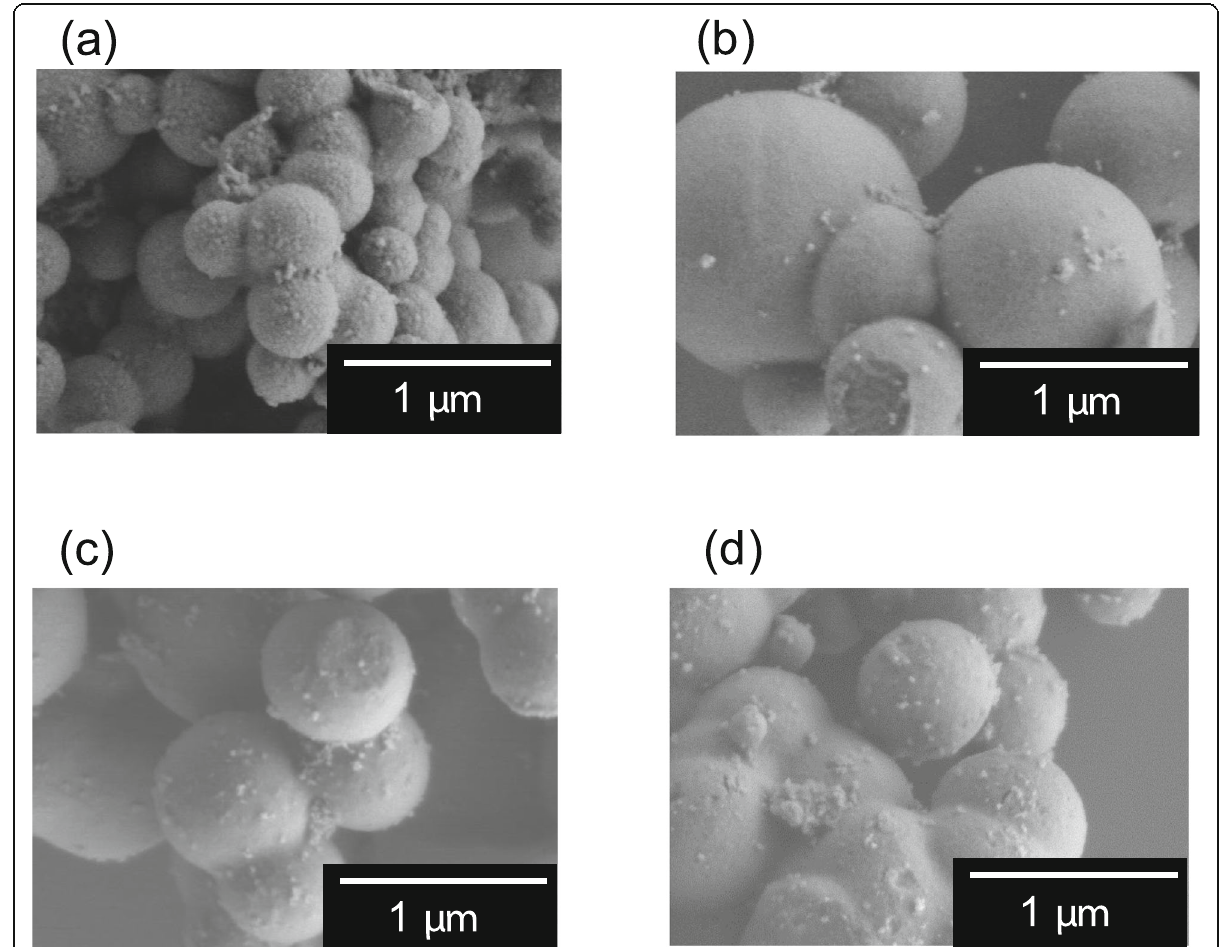
Fig. 4 SEM images of a HEMA-impregnated ZrO 2 MARIMO, b NIPAM-impregnated ZrO 2 MARIMO, c BMA-impregnated ZrO 2 MARIMO, and d CHMA- impregnated